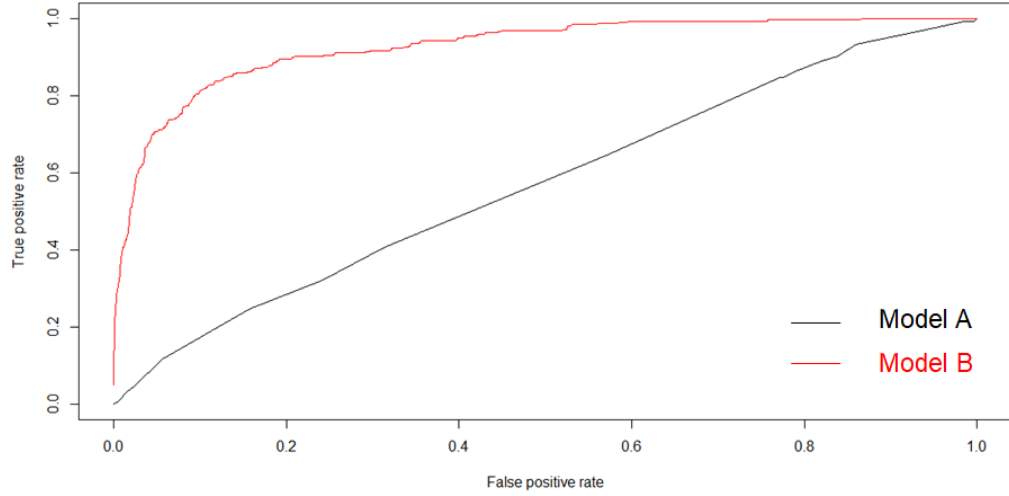
Figure 1. Area under the receiver operating characteristic curve (AUC) of model A and model B.